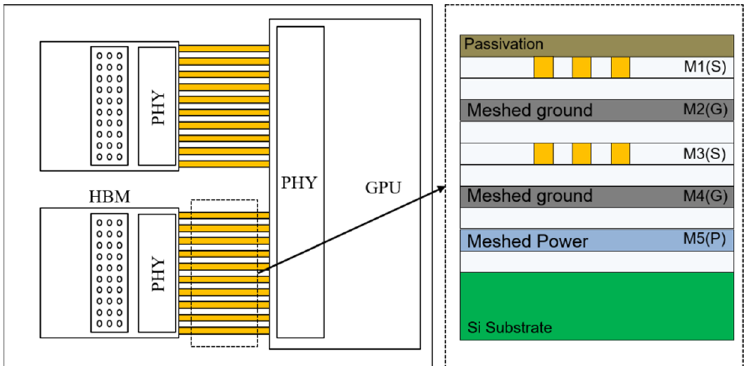
Figure 1. Conventional HBM interposer channel.